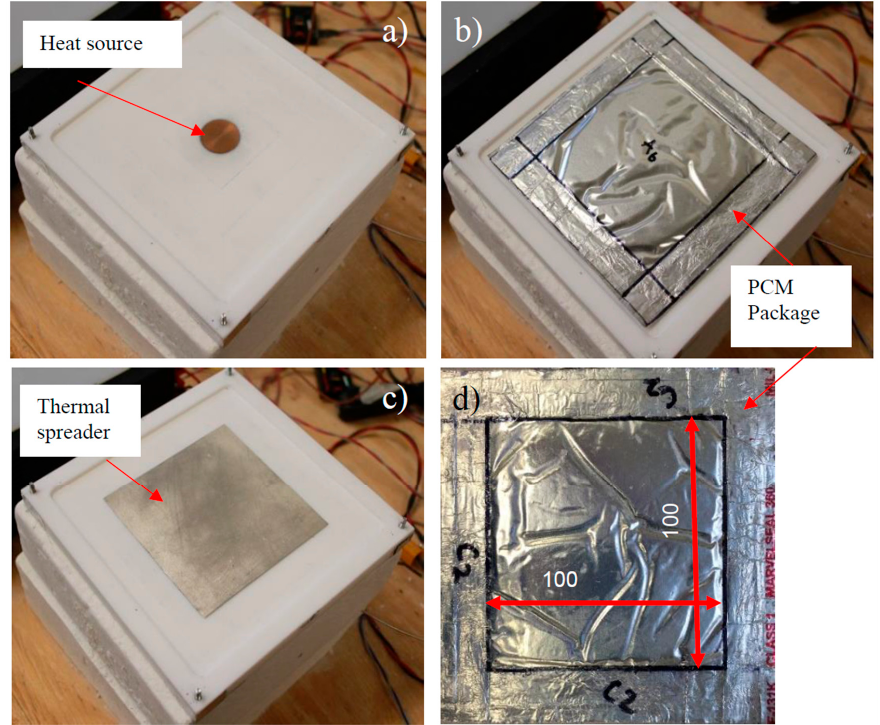
Figure 2. Photograph of the experimental setup ( a ) without any package, ( b ) with the thin PCM packet, and ( c ) with the thermal spreader; ( d ) one of the used PCM packages (dimensions in mm).